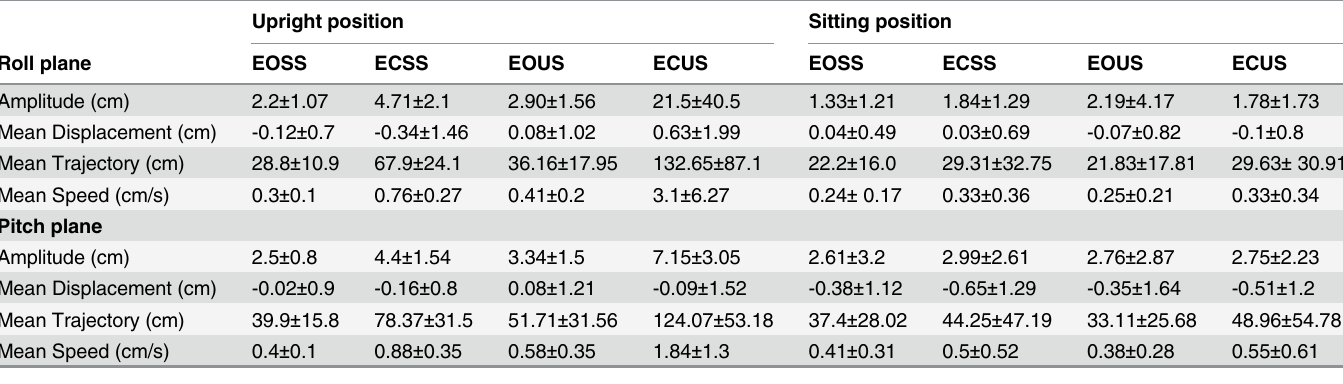
Table 2. Posturographic assessment of stroke patients. Data described as mean ± standard deviation. Upright position Sitting